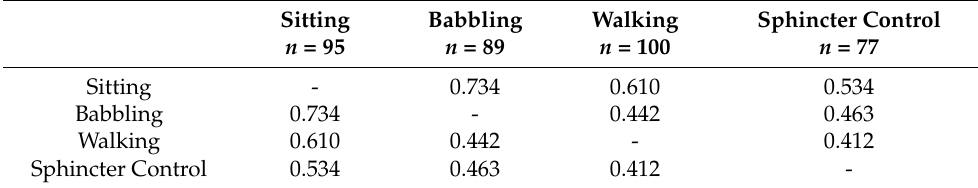
Table 3. Correlations between developmental